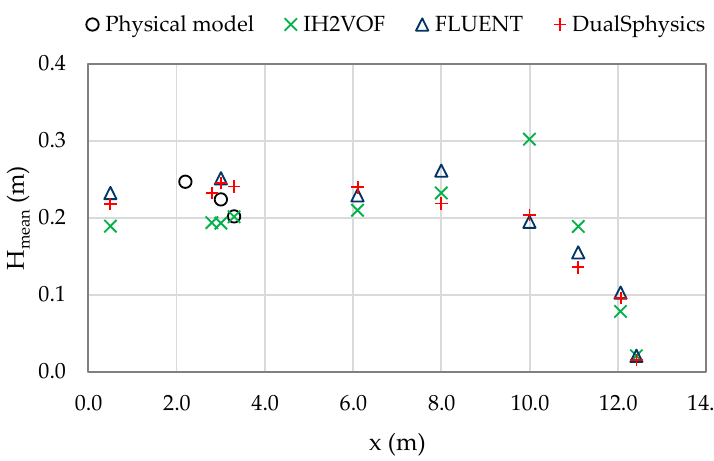
Figure 8. Wave height along the flume for test 5. elevation at section x = 3.0 m are compared in Figure 9 (test 1) and Figure 10 (test 5) and